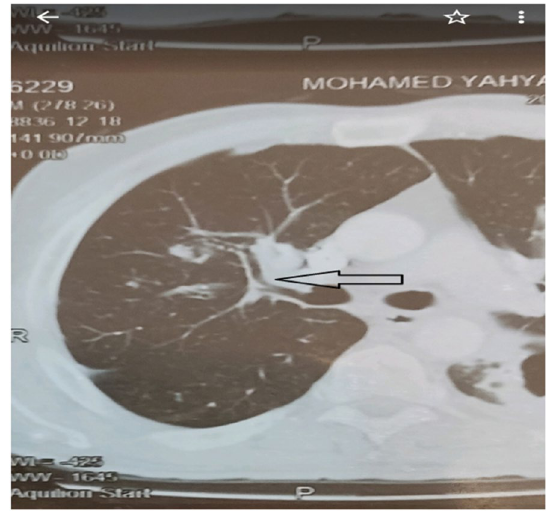
Fig. 3 CT of a male patient with ILI showing bronchial wall thickening